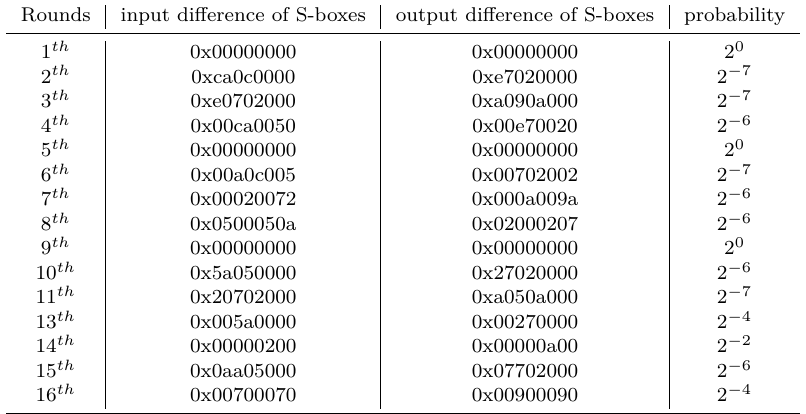
Table 16: The best differential characteristic with probability 2 − 68 for 15-round TWINE.